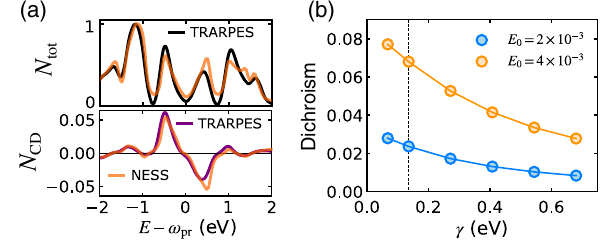
FIG. 7. (a) Comparison between the momentum-integrated unpolarized (upper) and dichroic (lower panel) signal for E 0 ¼ 4 × 10 − 3 a : u : obtained from TR-ARPES [same as in Fig. 6(d)] and from the NESS formalism. The effective temperature is set to 1 = 30 a : u : (b) Energy-integrated dichroism [extracted as in T eff ¼ Fig. 6(f)] as a function of the bath coupling strength γ . The dashed vertical line indicates the value of γ in